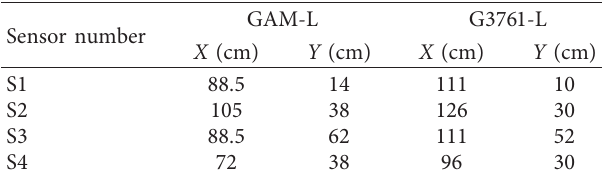
Figure 7: The sensor network layout for the plate-shaped rock in Scheme II. (a) GAM-L. (b) Table 9: The coordinates of sensors on the plate-shaped rock in Scheme II.